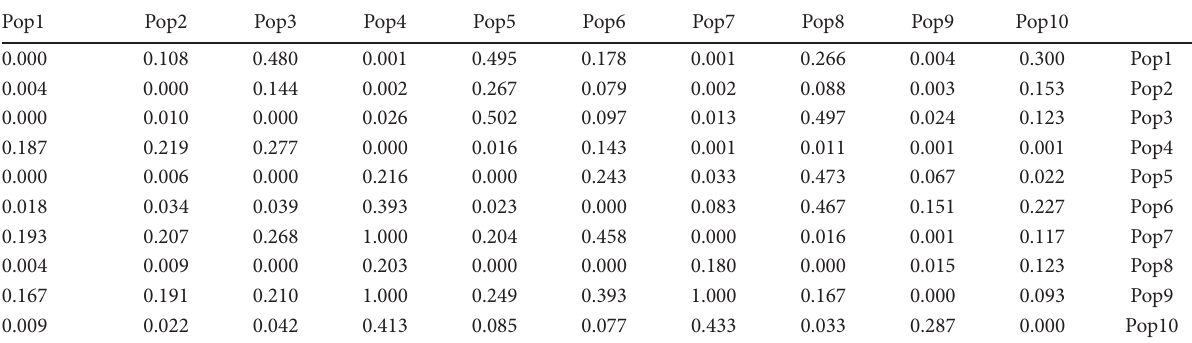
Table 3. Paired-sample AMOVA among geographical populations